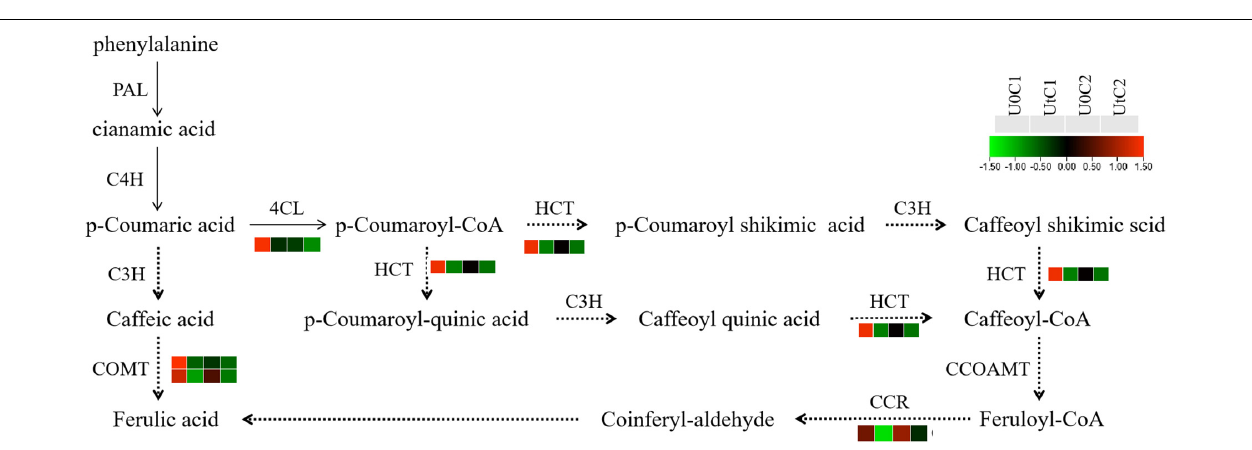
FIGURE 13 | Heatmap of differentially expressed genes (DEGs) related to ferulic acid synthesis in Mingui 1and Mingui 2. Heat maps were drawn using log2-transformed FPKM